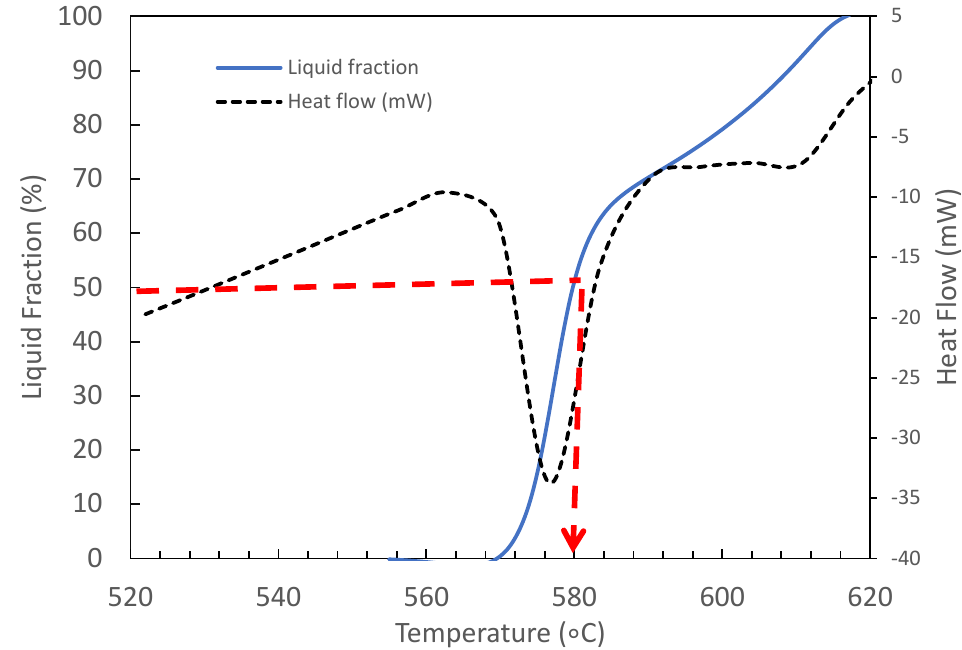
Figure 3. DSC and liquid fraction curve of 0.3 wt.% GNP/Al composite.